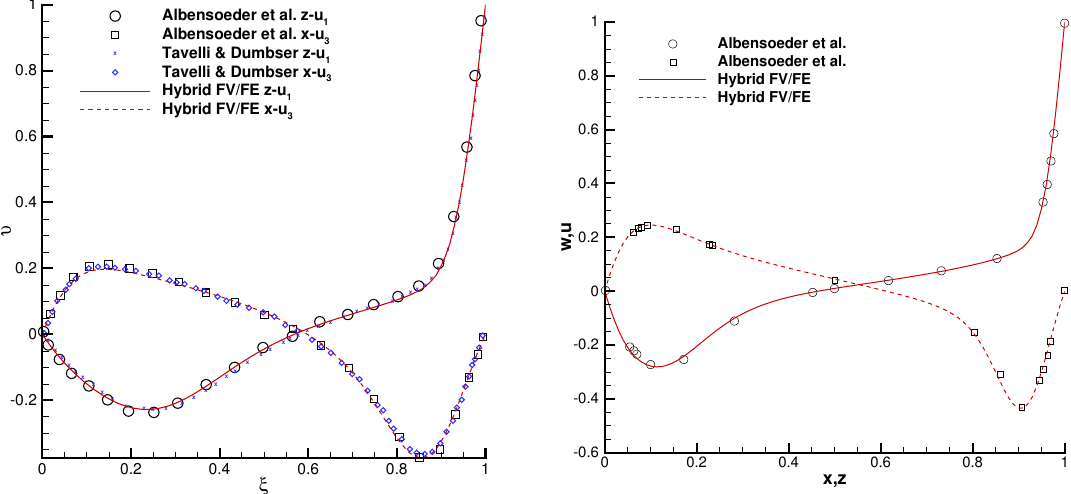
Figure 14. 1D cuts through the numerical solution for the 3D lid–driven cavity at time t = 40 and comparison with available numerical reference solutions in [48,94]. ( Left ): Re = 400. ( Right ): Re =